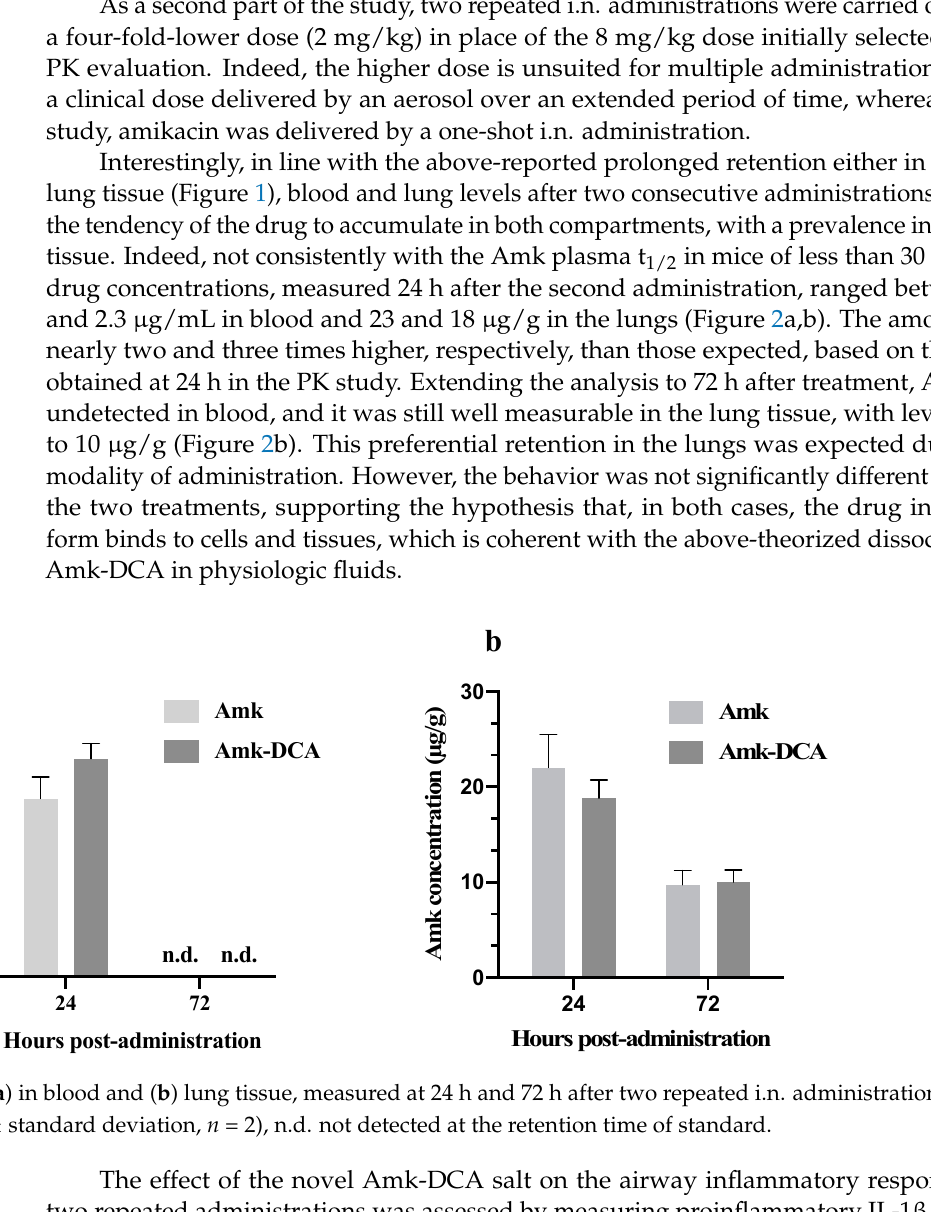
6 of 12 Table 1. Lung and blood pharmacokinetic parameters after i.n. instillation of Amk and Amk-DCA in CD1 mice (mean ± S.D., n = 6). Parameter Amk Solution Amk-DCA Suspension Lung Blood